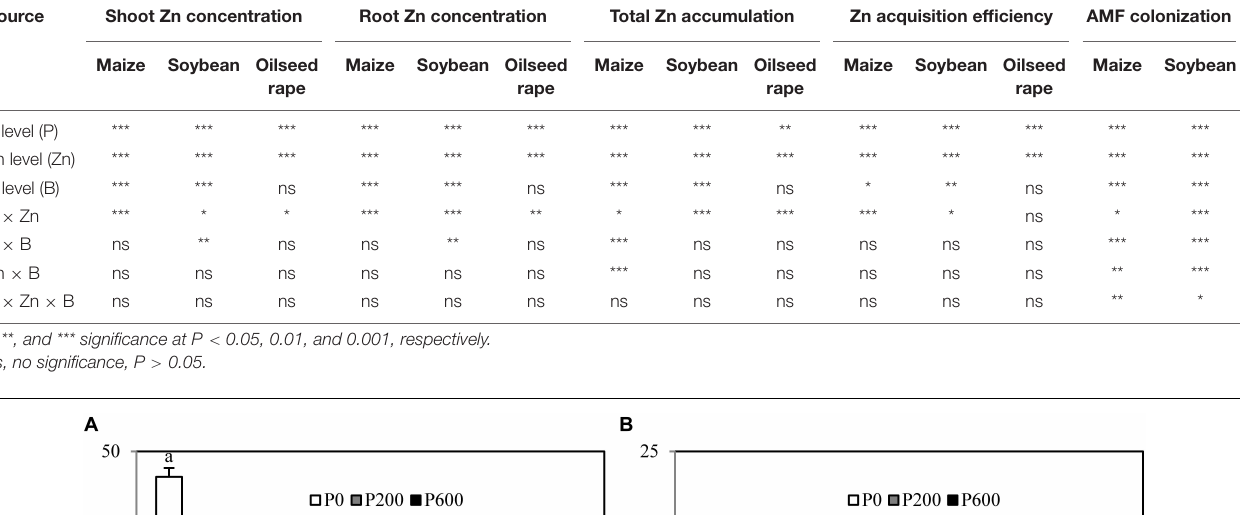
TABLE 2 | Analysis of variance for the effects of P application (P), Zn application (Zn), benomyl addition (B), and their interactions on Zn concentration in shoots and roots, total Zn accumulation, Zn acquisition efficiency, and arbuscular mycorrhizal fungi (AMF) colonization of maize, soybean, and oilseed rape, respectively. Source Shoot Zn concentration